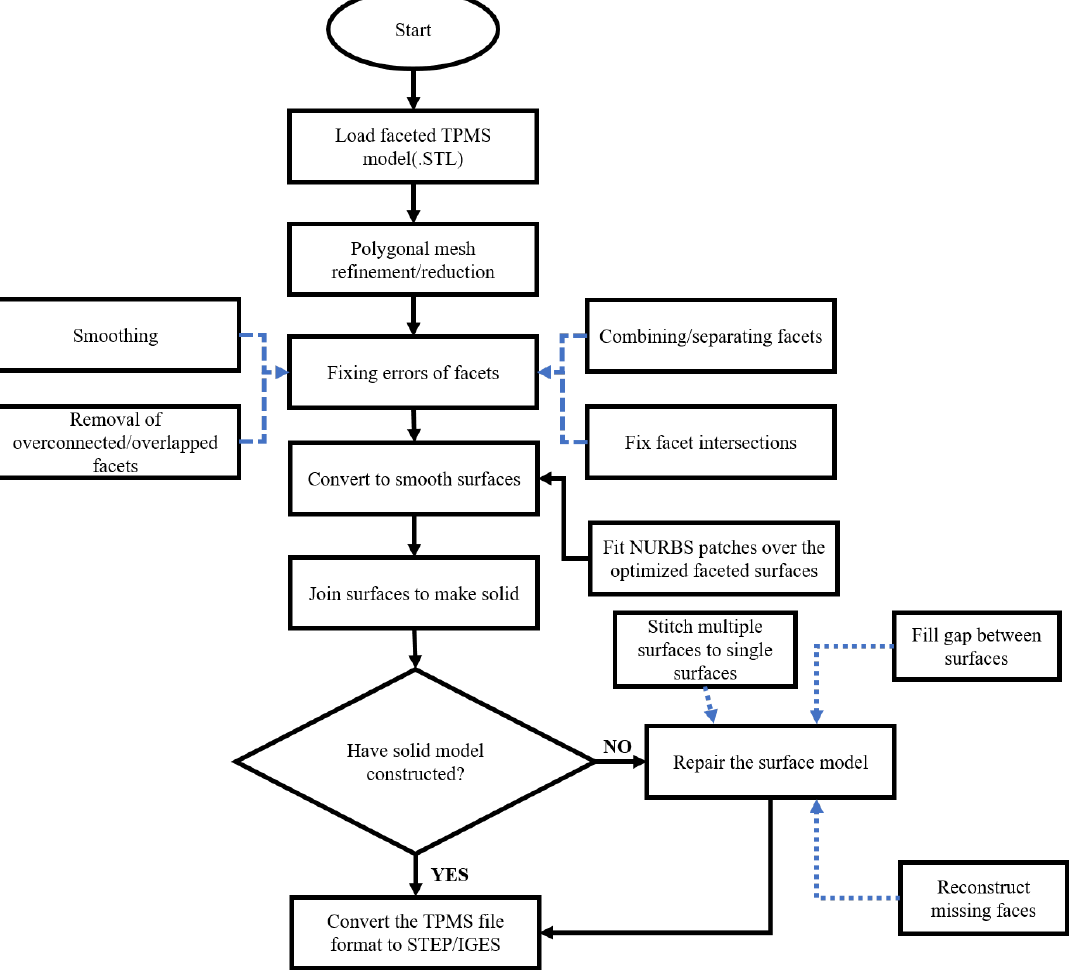
Figure 2. Process flow diagram for the conversion of TPMS STL data to multiscale CAD design.